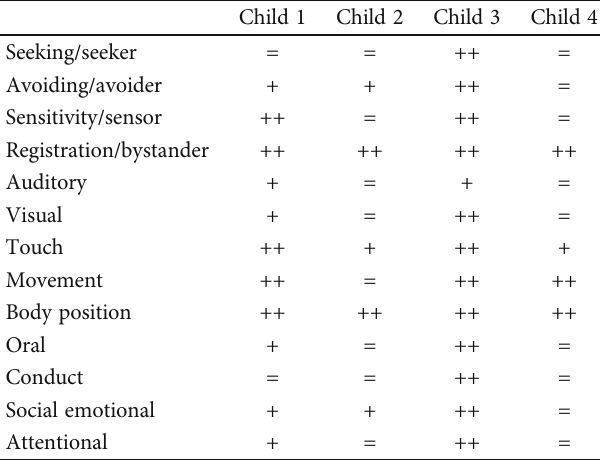
Table 1: Sensory